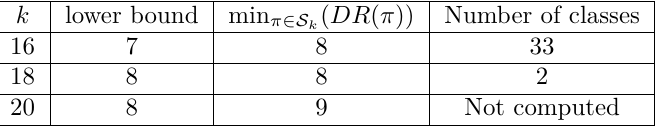
Table 9: Fibonacci lower bounds and optimal diffusion